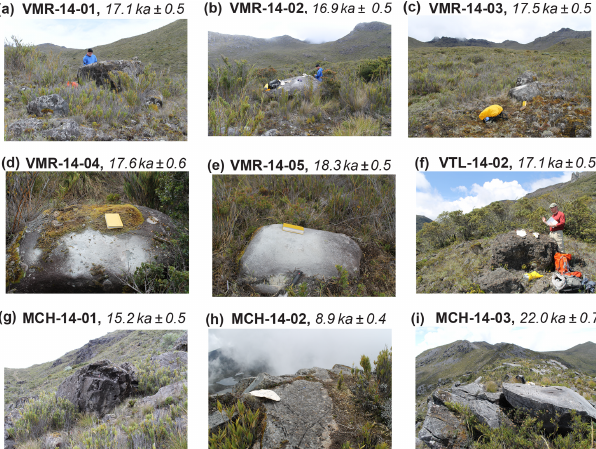
Figure 7. 10 Be sample locations for Cerro Chirripó. (a–e) Boulders (diorite) perched on recessional moraines in Valle de las Morrenas. (f) Boulder (andesite with quartz veins) perched on lateral moraine in Valle Talari. (g) Postglacial landslide boulder. (h–i) Scoured bedrock along divide separating Valle de las Morrenas from Valle de los